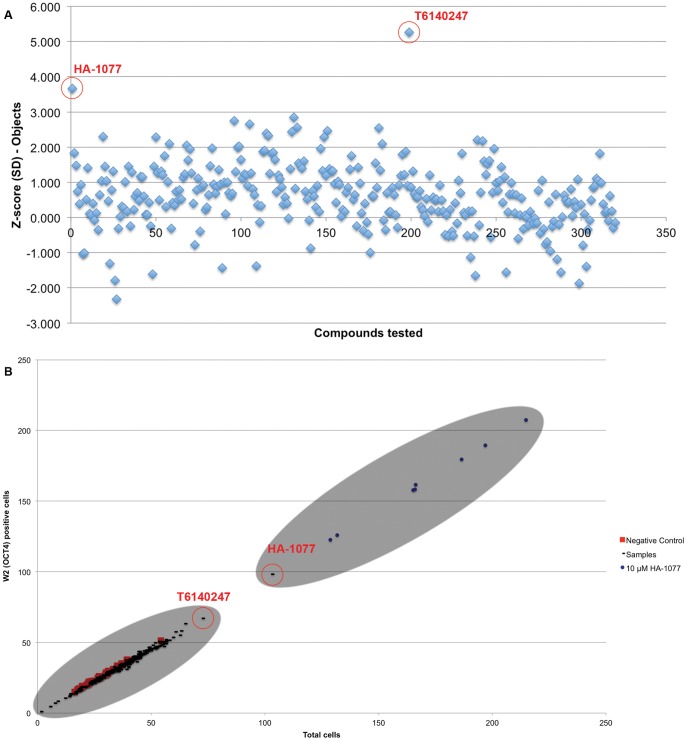
Secondary assays confirmed the pro-survival effects of the ROCK inhibitor HA-1077 on OCT4 positive hESCs.
A: 320 candidate small molecules were rescreened in identical conditions to the primary assay. 2 small molecules circled in red, HA-1077 and T6140247, resulted in a significant (Z score ≥3 SD) improvement in viable Calcein positive objects. B: As a secondary assay, the 320 candidate molecules were screened at 1500 cells per well. After two days, cells were stained with the pluripotency marker OCT4 and counterstained with Hoechst 33342, in place of Calcein staining. The compounds identified in (A) are again circled. T6140247 is found clustered with other experimental samples (black) and negative control wells (red), while HA-1077 is found clustered with positive control wells treated with 10 µM HA-1077 (blue).